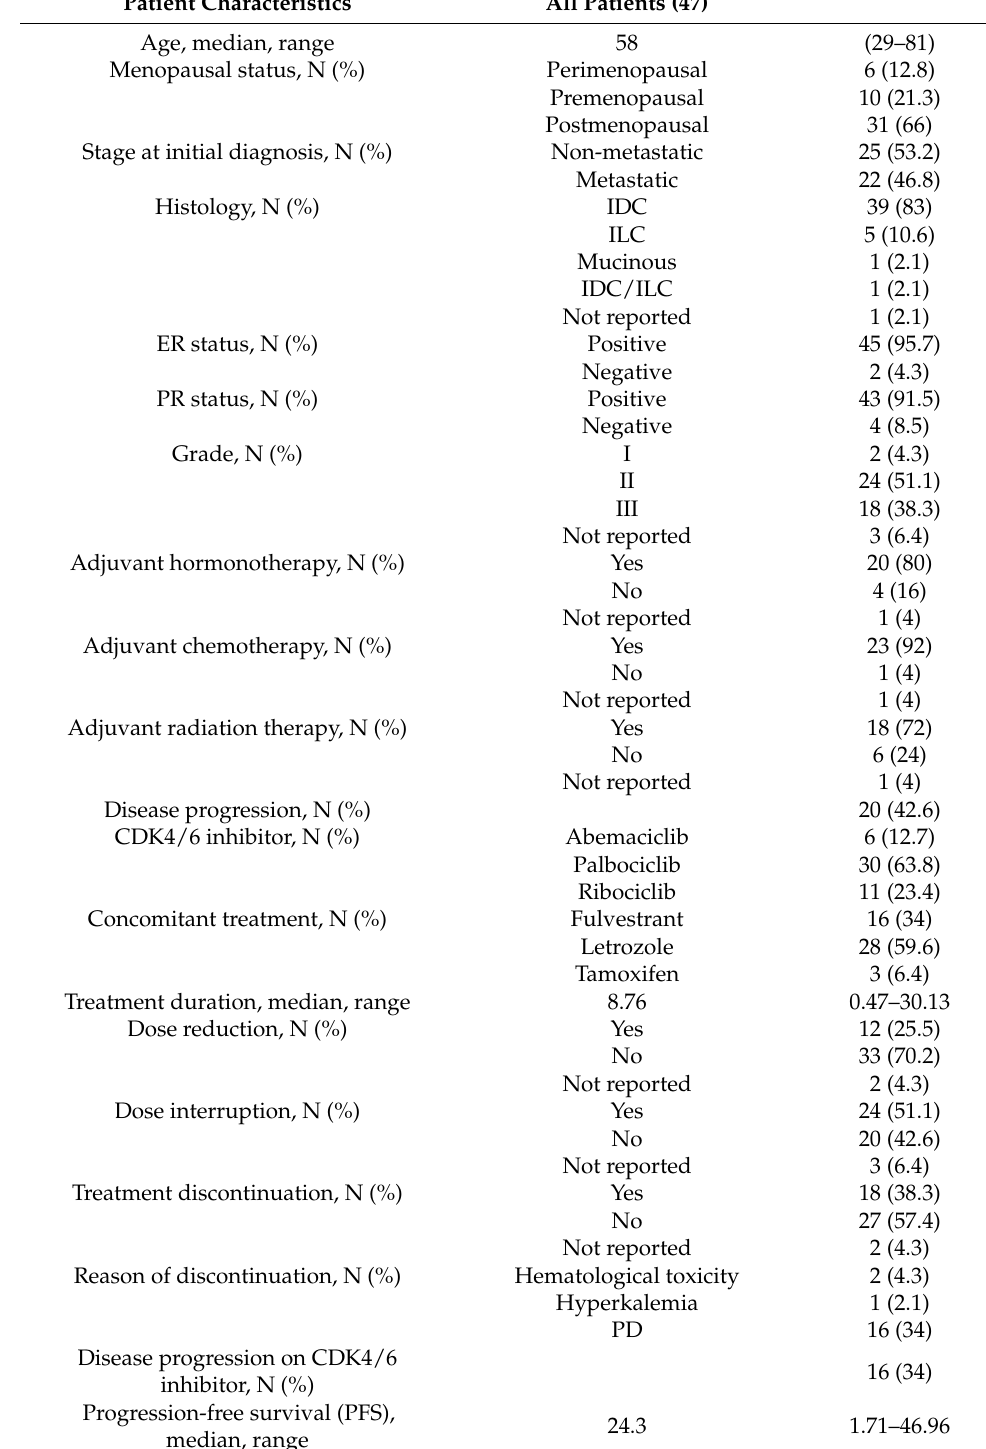
Table 2. Baseline characteristics of